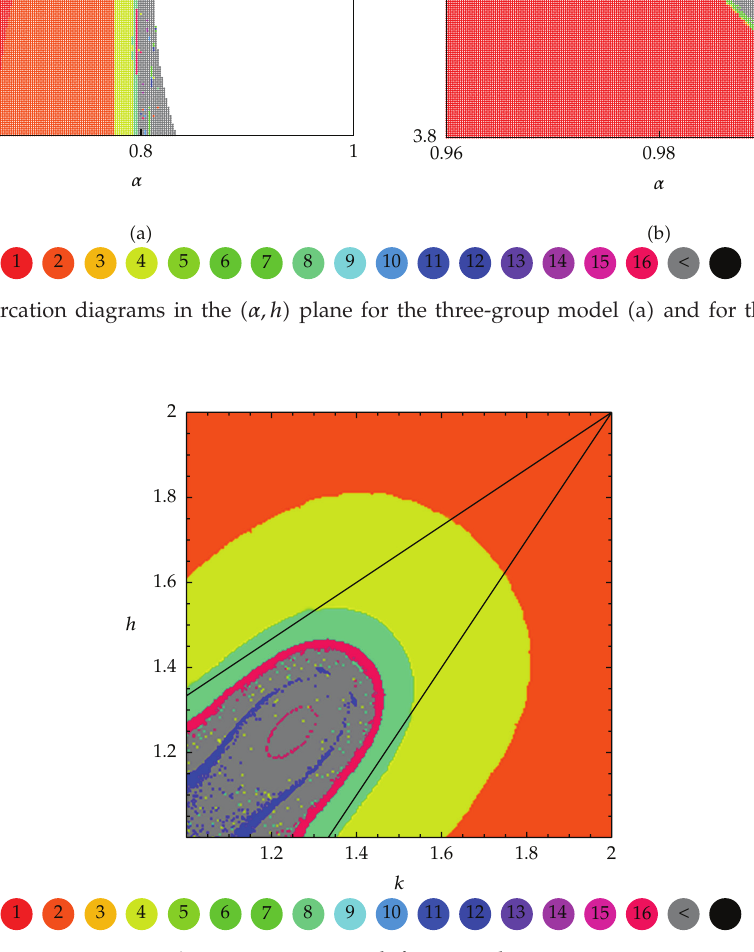
Figure 6: 2-parameter bifurcation